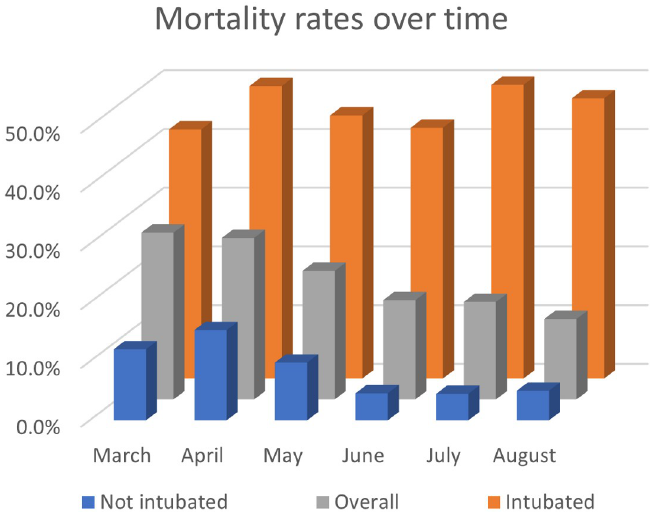
Fig 1. Mortality rates over time in adults with COVID-19 and acute respiratory distress syndrome or acute respiratory failure. Mortality rates over time from March 2020 to August 2020 by mechanical ventilation status. “Overall” includes all patients, “Intubated” includes only patients that required mechanical ventilation, and “Not intubated” includes only patients that did not require mechanical ventilation during their hospital